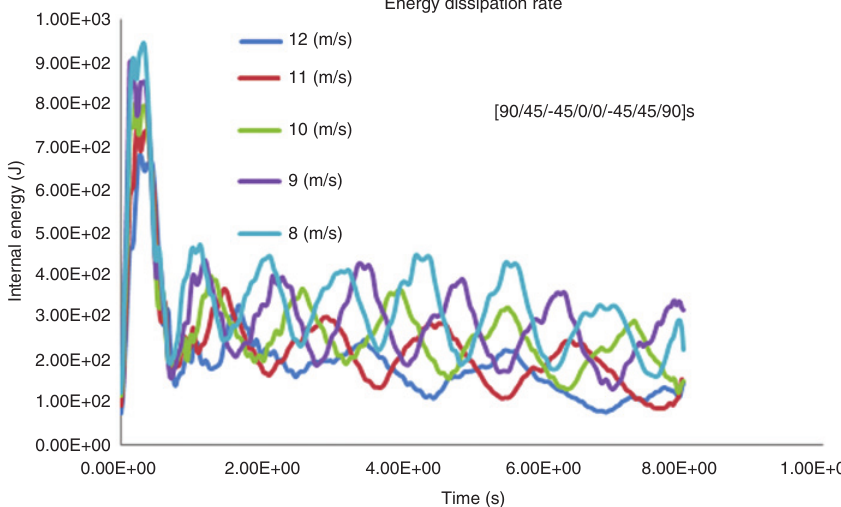
Figure 9 Energy dissipation rate of the stacking sequence of [90/45/-45/0/0/-45/45/90]s at various impacting